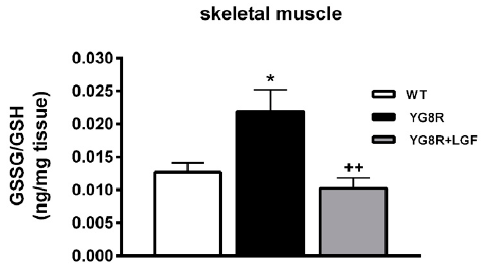
Figure 8. LGF treatment decreases oxidative stress in YG8R mice skeletal muscle. The figure represents the ratio of oxidized glutathione (GSSG) to reduced glutathione (GSH) in the skeletal muscle of WT ( white bar), YG8R ( black bar), and YG8R+LGF ( gray bar) mice. Note that the ratio is significantly increased in YG8R mice versus WT mice, while LGF treatment restores this alteration. Results are the mean ± SEM of 6–8 independent animals. * p < 0.05 vs. WT; ++ p < 0.01 vs. YG8R.